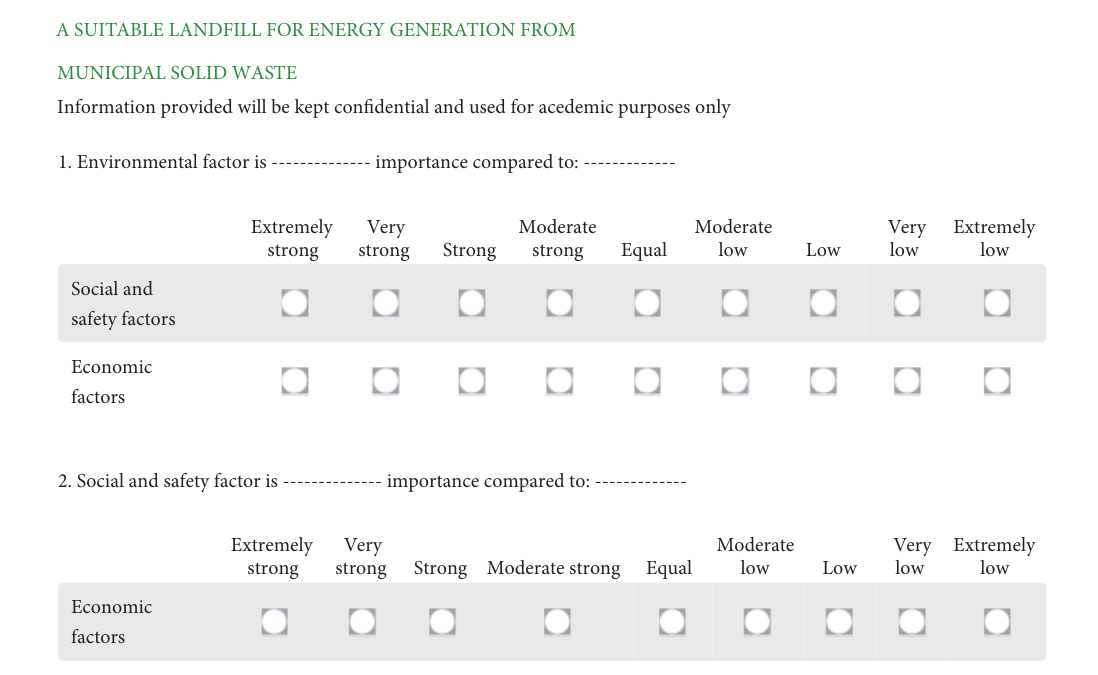
Figure 6: Part of the questionnaire in the MCDA. Table 2: Pairwise comparison on each